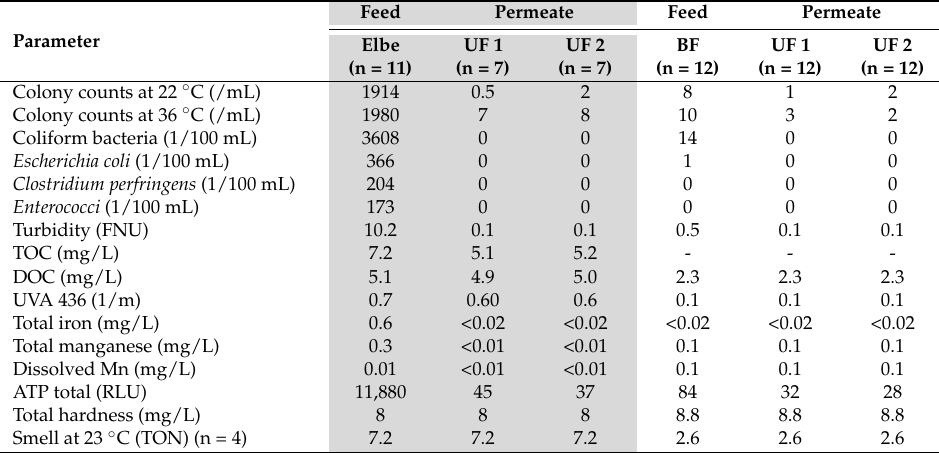
Table 1. The water quality of feed water and permeate from the ultrafiltration plant (average values shown; for standard deviation and convergence see Table A1 in Appendix A). Parameter